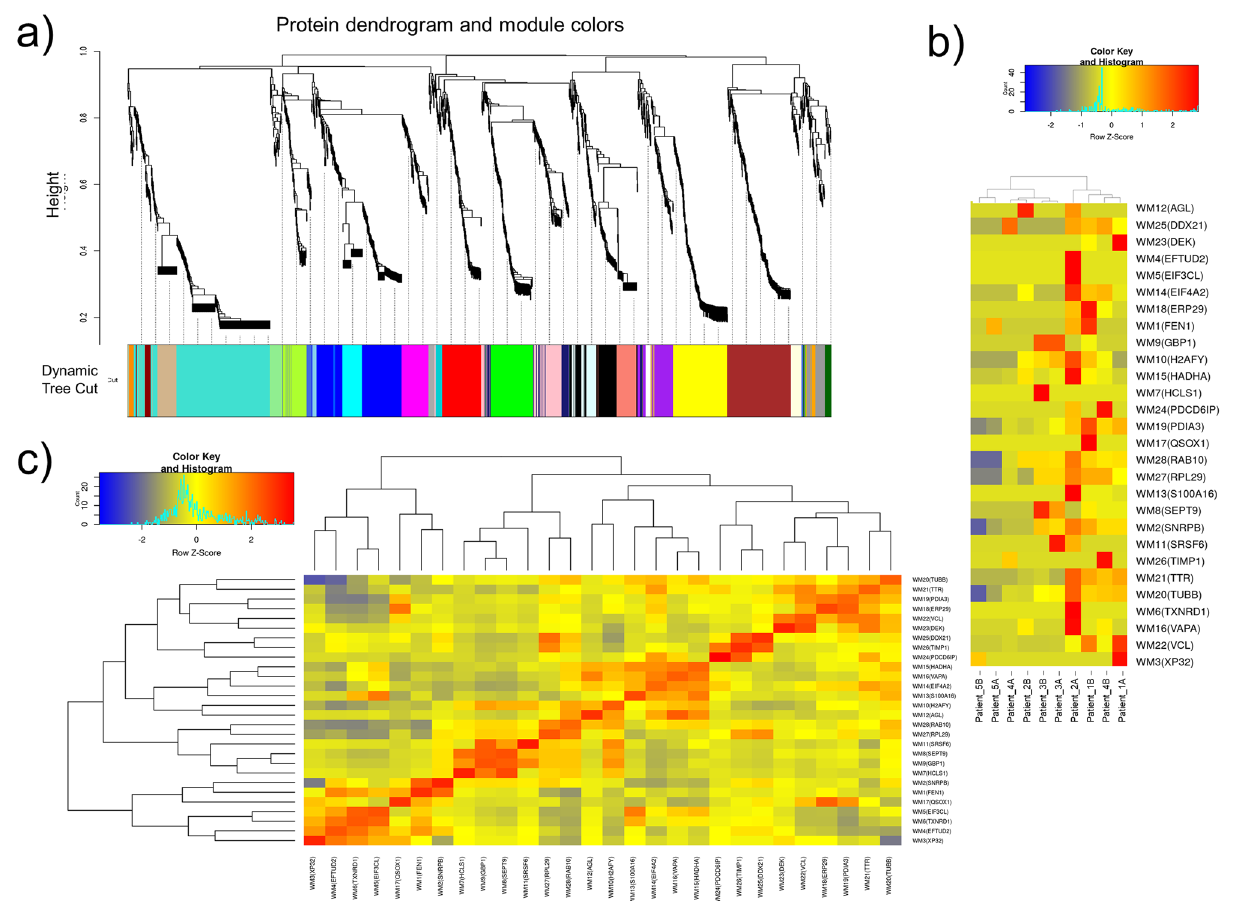
Figure 1. Protein modules identified by weighted gene co-expression network analysis (WGCNA). ( a ) Protein dendrogram obtained by clustering the dissimilarity based on consensus topological overlap with the corresponding module. Colored rows correspond to the 28 modules identified. ( b ) Dendrogram of consensus module eigen-proteins obtained on the consensus correlation. ( c ) Pairwise correlations between the modules in the heatmap of eigen-protein